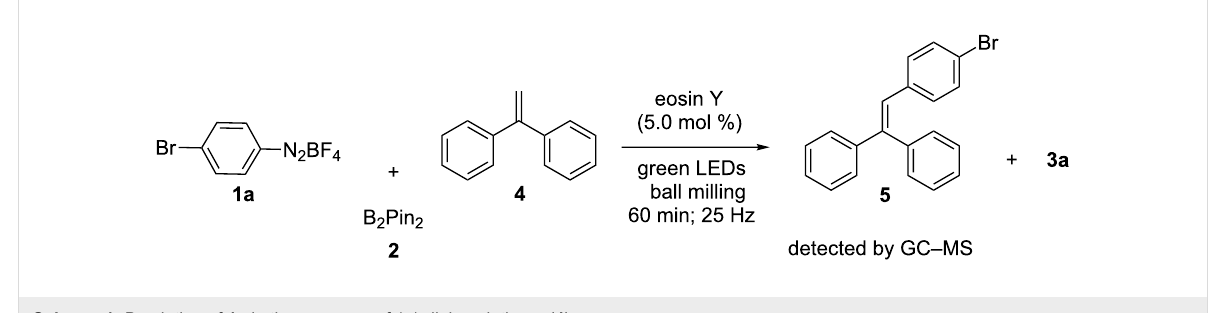
Table 2: Borylation of aryl diazonium salts 1 with 2 .